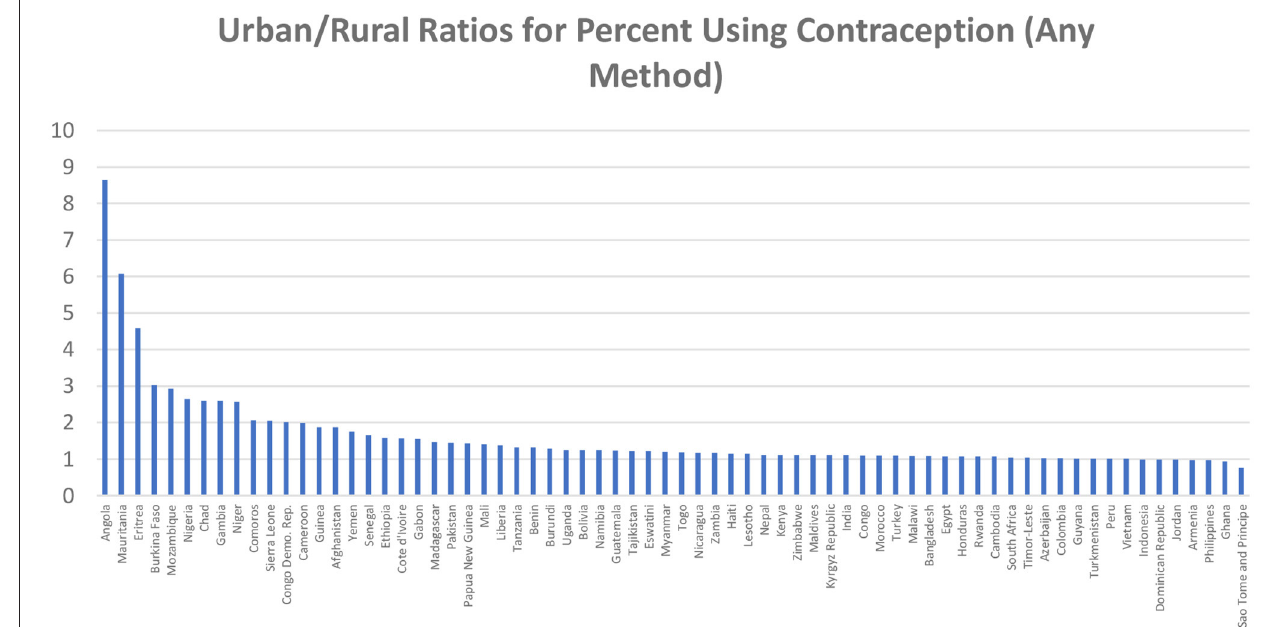
FIGURE 3 | Urban/rural ratios for percent using contraception (any